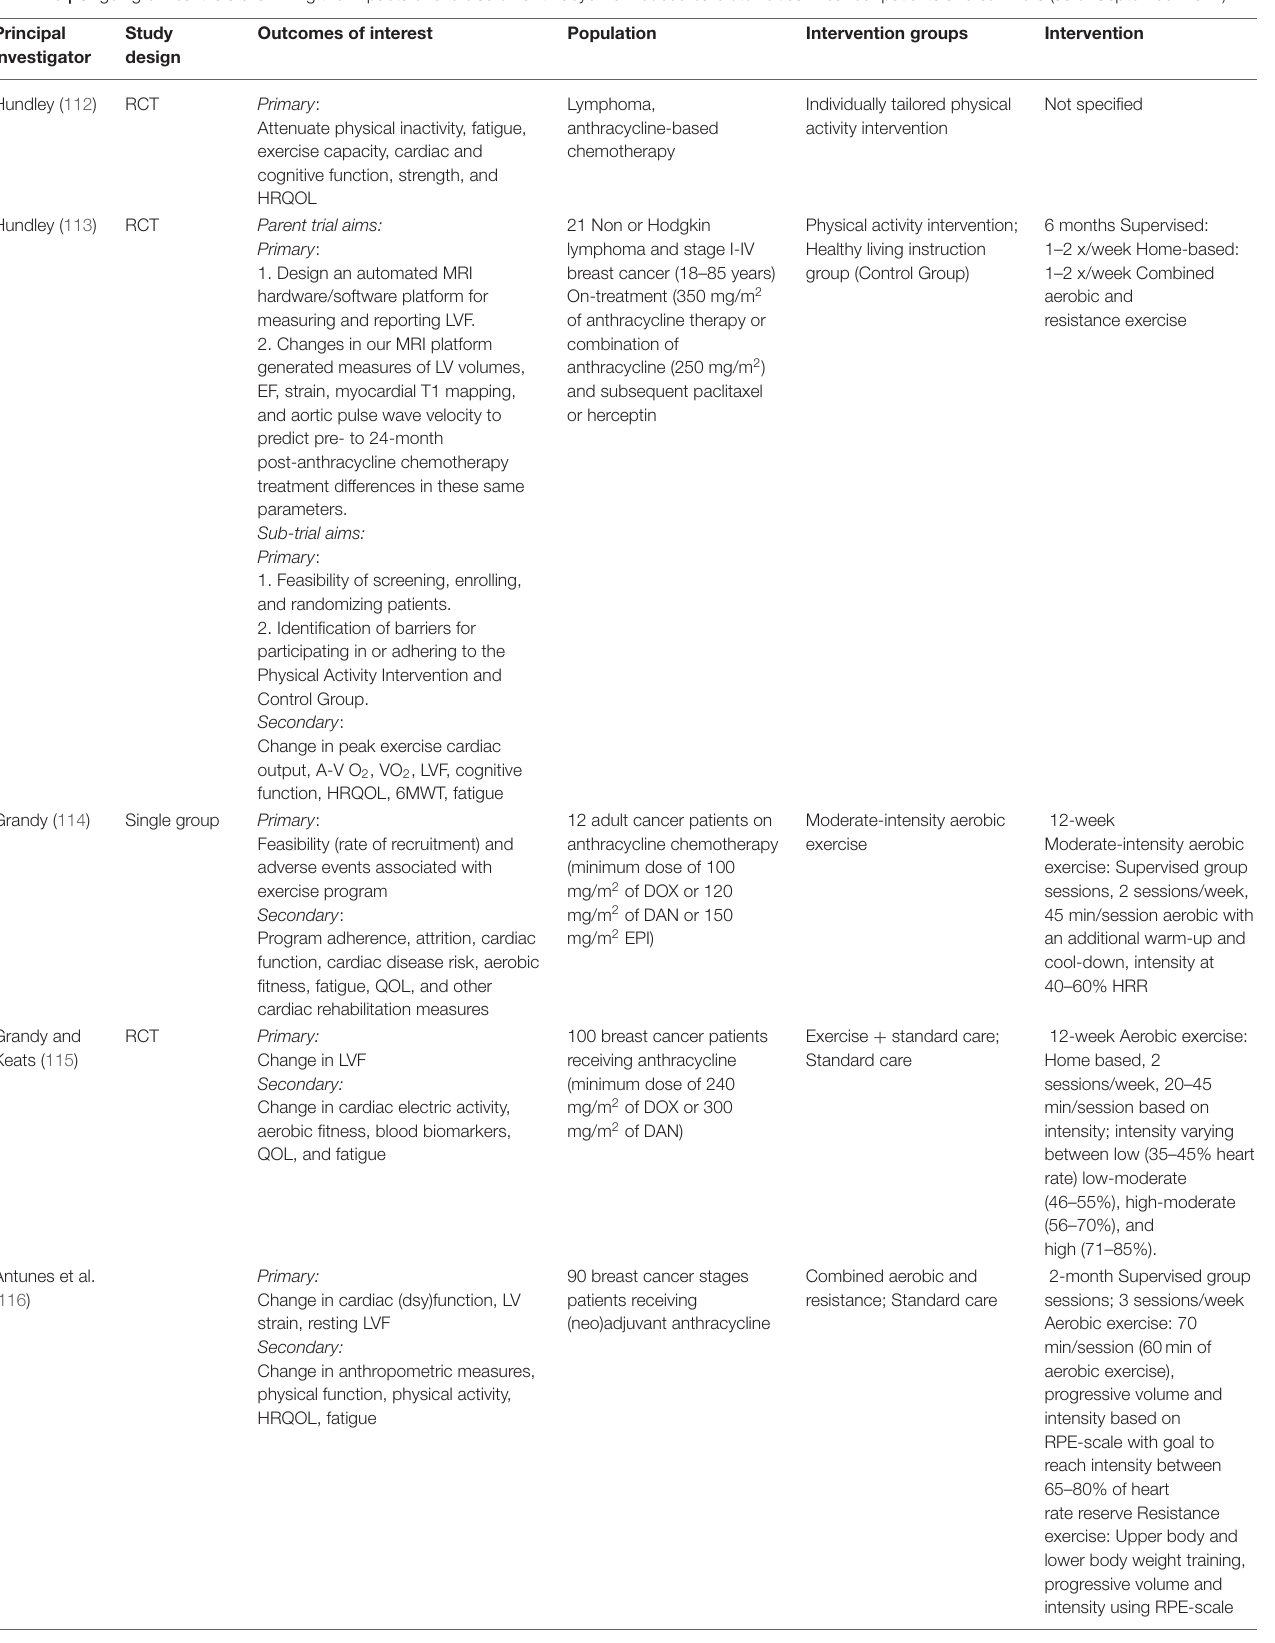
TABLE 3 | Ongoing clinical trials examining the impacts of exercise on anthracycline-induced cardiotoxicities in cancer patients and survivors (as of September 2021). Principal